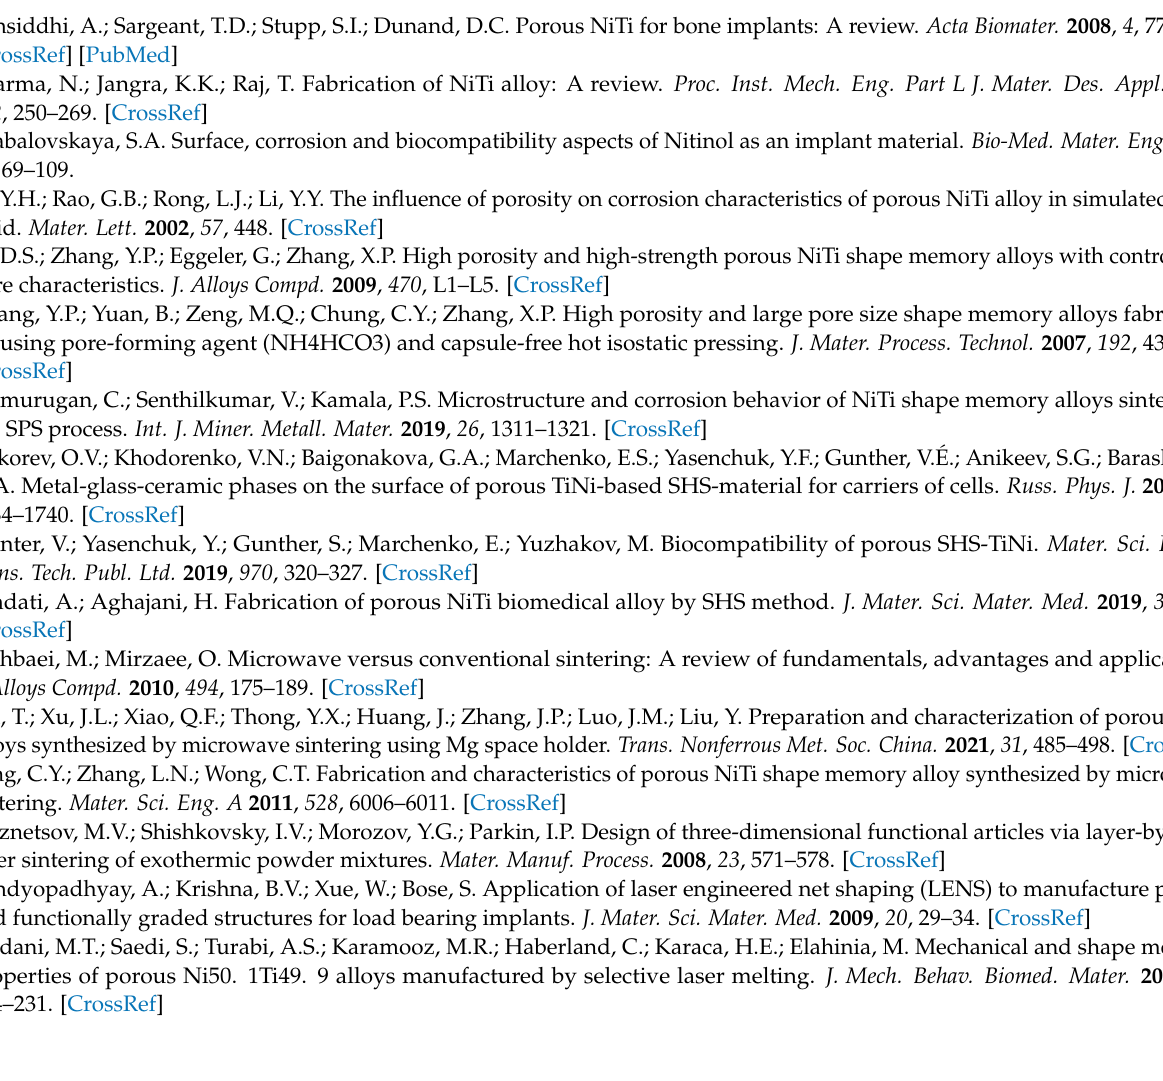
The sintered porous NiTi alloy was composed of the major NiTi phase with a few Ti 2 Ni and Ni 3 Ti second phases, and the relative intensity of the NiTi phase increased with the temperature. It presented a typical brittle fracture. The pore structure and mechanical properties of samples can be tailored by controlling sintering temperature. A porous NiTi alloy with the porosity of 38.9%, the compressive strength of 254 MPa and the elastic modulus of 4 GPa was obtained at the sintering temperature of 1000 ◦ C for 30 min, which could be in accord with the demand for bone